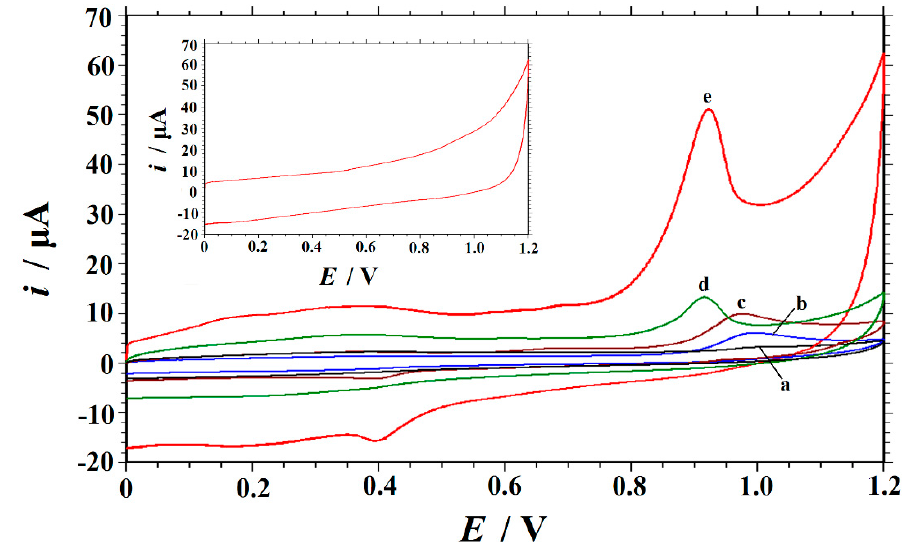
Figure 4. Cyclic voltammograms of 10 μ M Trp obtained at different electrodes in 0.05 M H 2 SO 4 solution. Curve a: bare GCE; curve b: GO/GCE; curve c: Cu 2 O ‒ GO/GCE; curve d: ERGO/GCE; and curve e: Cu 2 O ‒ ERGO/GCE. Scan rate: 0.1 V·s − 1 . Inset: the cyclic voltammogram of Cu 2 O ‒ ERGO/GCE in 0.05 M H 2 SO 4 solution. Table 2. Detailed data of cyclic voltammograms of 10 μ M Trp at different electrodes.